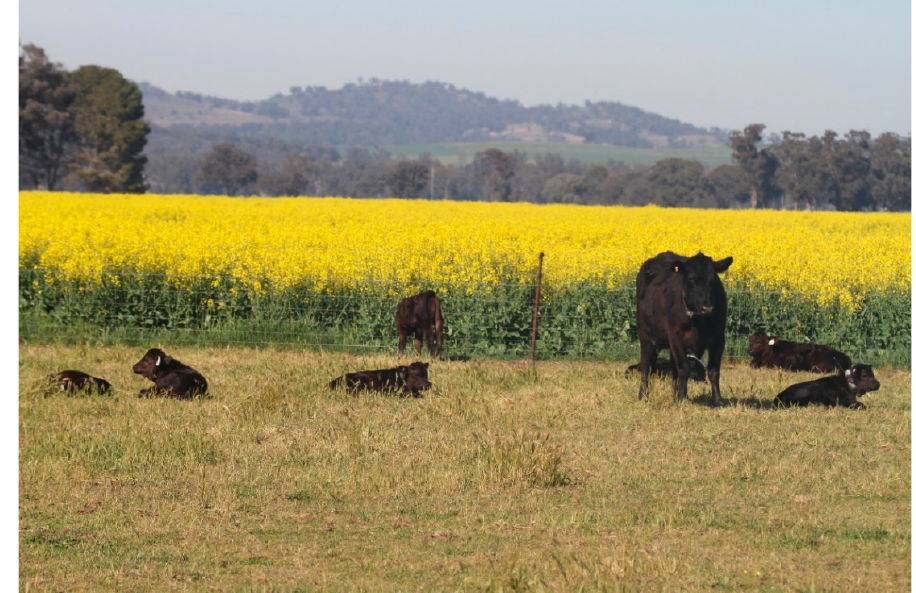
Figure 3. Example of a ‘crèche’ formed by a mature Angus beef cow.